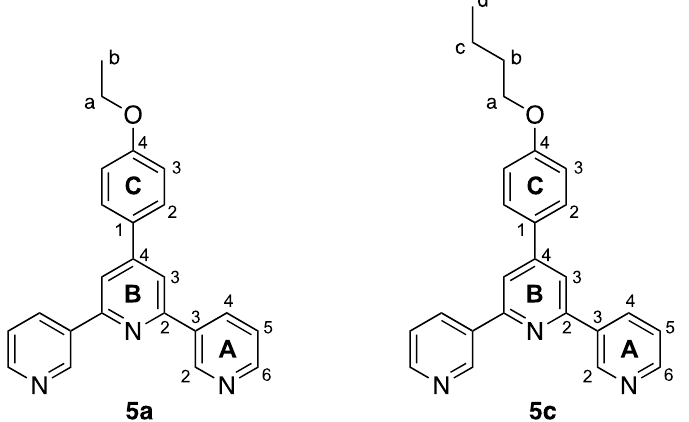
Figure 3. Structures of compounds 5a and 5c with atom labelling for NMR spectroscopic assignments.